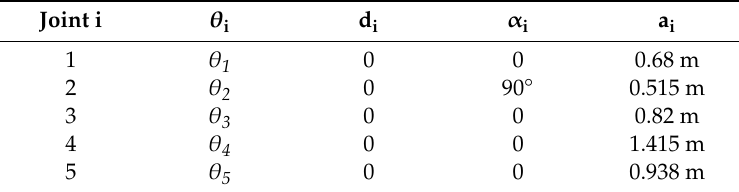
Table 1. Modified D-H parameters of demolition